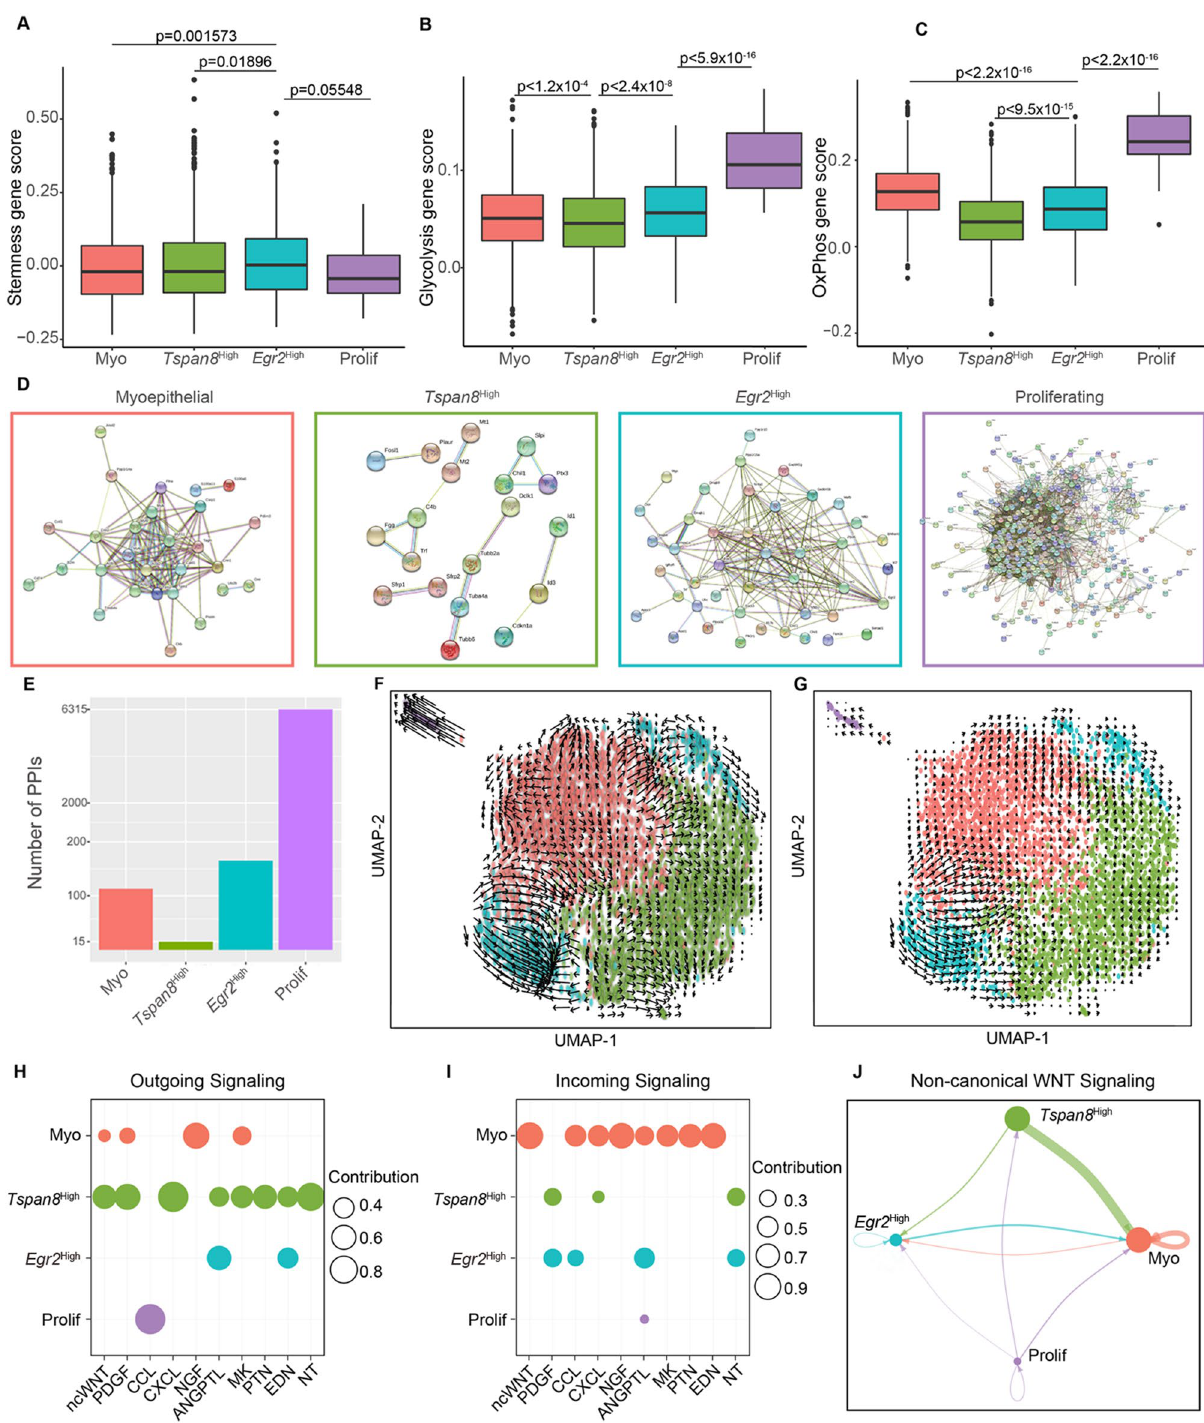
Figure 2. Molecular features of the basal transcriptional states. ( A – C ) Boxplots displaying gene scoring of each basal transcriptional state using gene signatures for mammary stemness ( A ), glycolysis ( B ), and OxPhos ( C ). p values in ( A - C ) were generated using Mann–Whitney U tests. ( D ) PPIs for each cell state (myoepithelial, pink; Tspan8 High , green; Egr2 High , blue; proliferating, purple), where each node is protein coded by the marker gene and each edge is a predicted direct or indirect interaction. ( E ) Bar plots displaying the number of PPIs for each transcriptional state. ( F – G ) Projections of RNA Velocity fields onto UMAP from Fig. 1B using linear ( F ) and non-linear ( G ) models. ( H – I ) Dot plots indicating the outgoing ( H ) and incoming ( I ) signaling contributions from each transcriptional state for significant signaling pathways identified. ( J ) Signaling pattern of non- canonical WNT